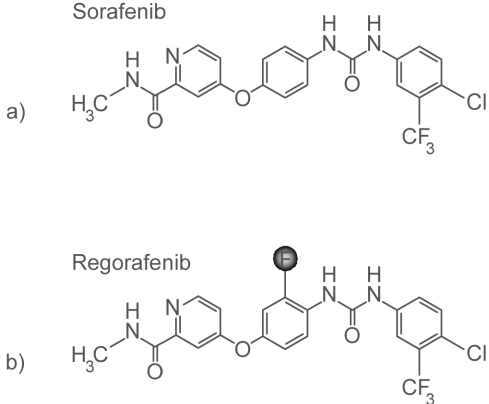
Figure 4. Chemical structures of ( a ) sorafenib and ( b )